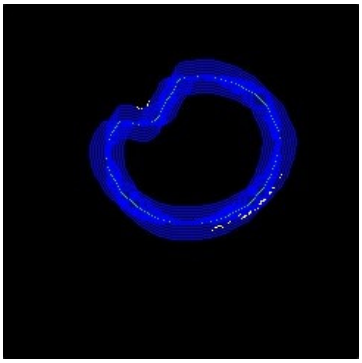
Figure 38. Coincident contour vertex image.